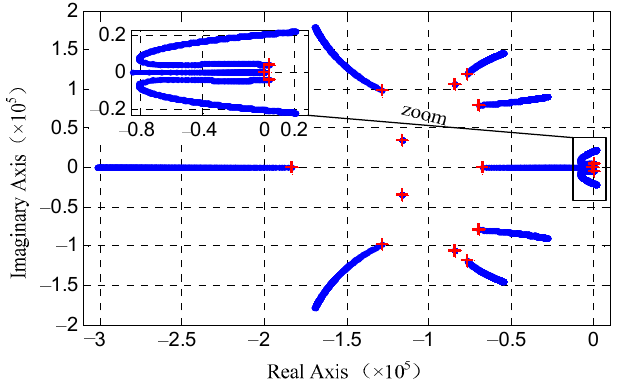
Figure 5. Zero locus of Z a as k p varies from 10 − 4 to 5 × 10 − 3 with a step of 10 − 5 .